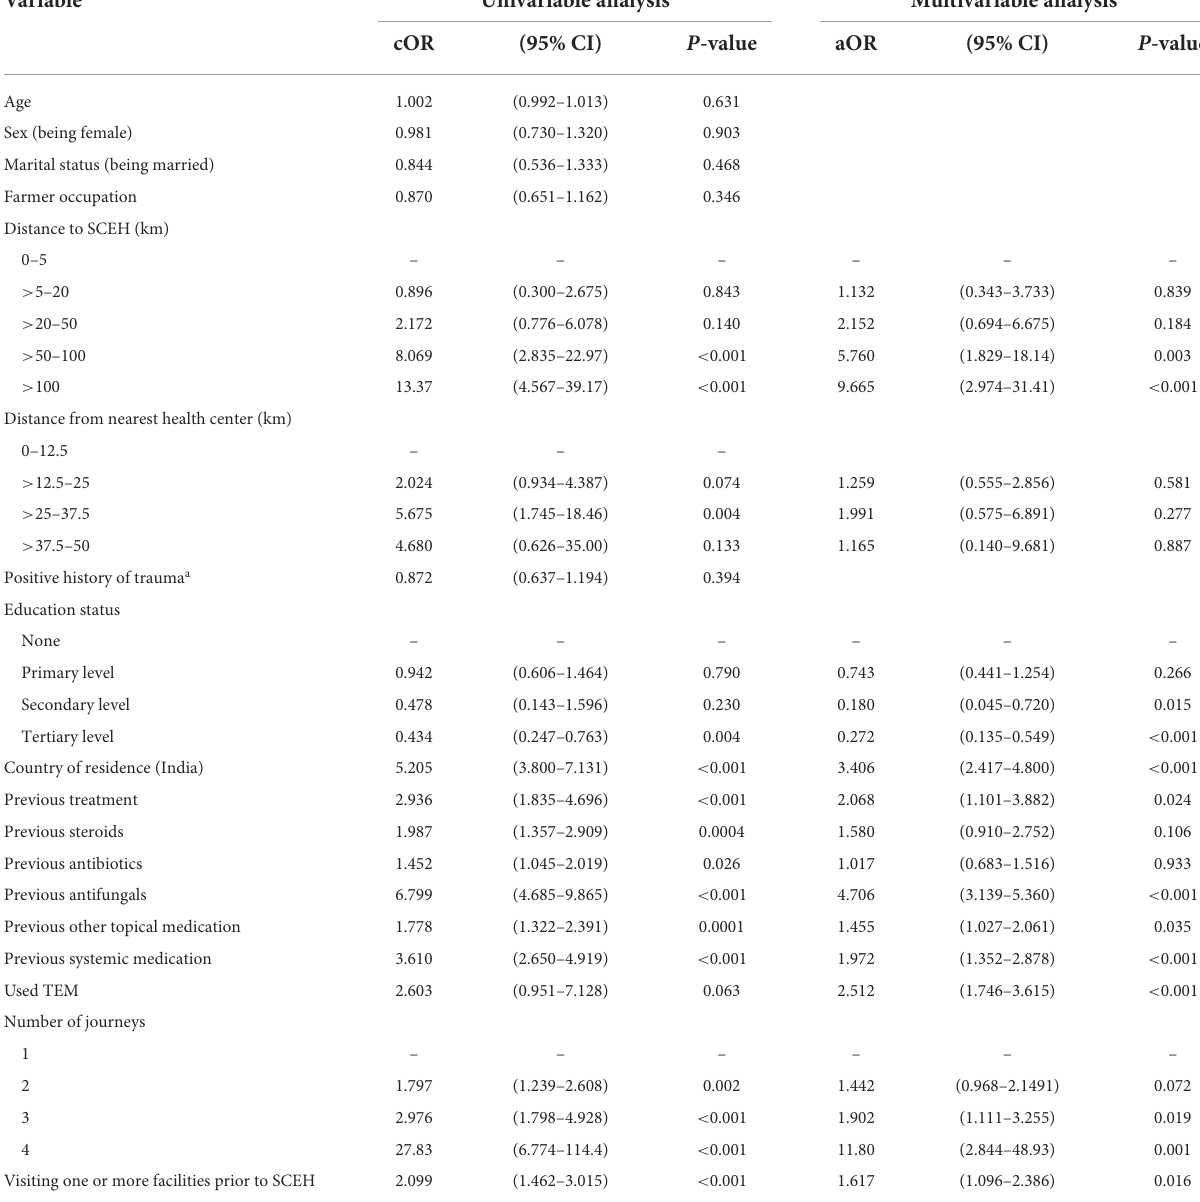
TABLE 5 Univariable and multivariable ordinal logistic regression analysis of factors associated with delay among patients with microbial keratitis ( n =